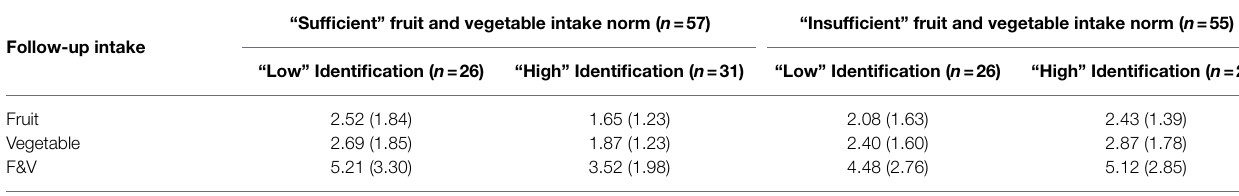
F (1, 103) Fruit Vegetable Fruit Vegetable Fruit Vegetable